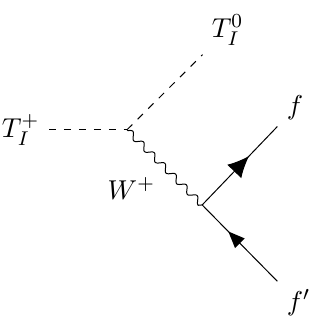
Figure 5 . The three body decay of the charged